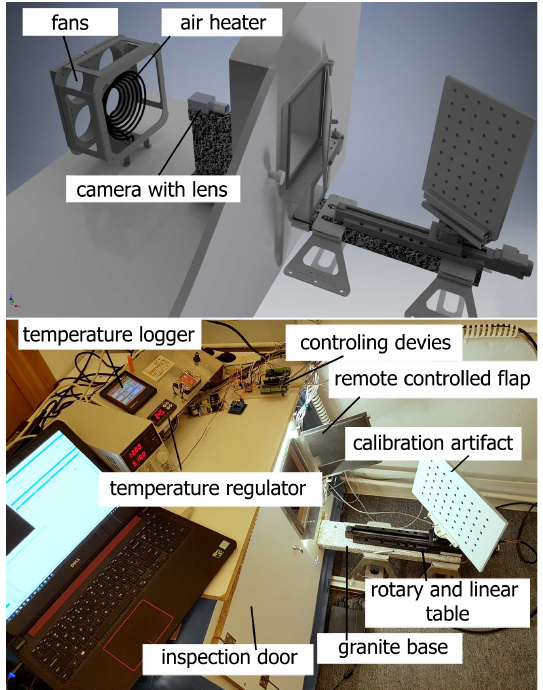
Figure 1. The designed thermal chamber and the test stand, demonstrating the experimental setup. To detect the image drift, we used the a calibration artifact: a 9 × 6 matrix of black circle markers (the first marker is located on the bottom left) printed on a matte white foil stuck to a glass plate. This artifact was previously validated on a coordinate measurement machine (CMM) equipped with a Carl Zeiss Viscan Optical Header (Figure 2) so that the precise coordinates of the center of every marker were determined.